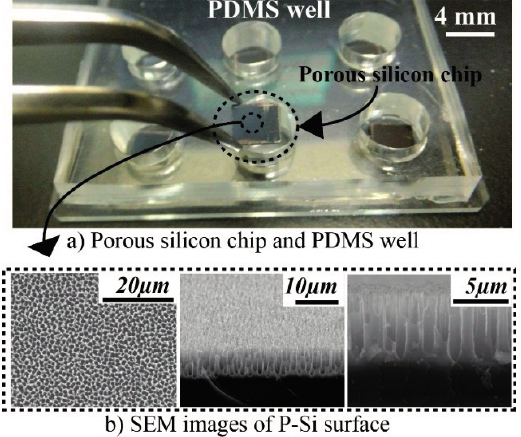
Figure 2. Porous silicon (P-Si) matrix used for microarrays. P-Si chips and PDMS